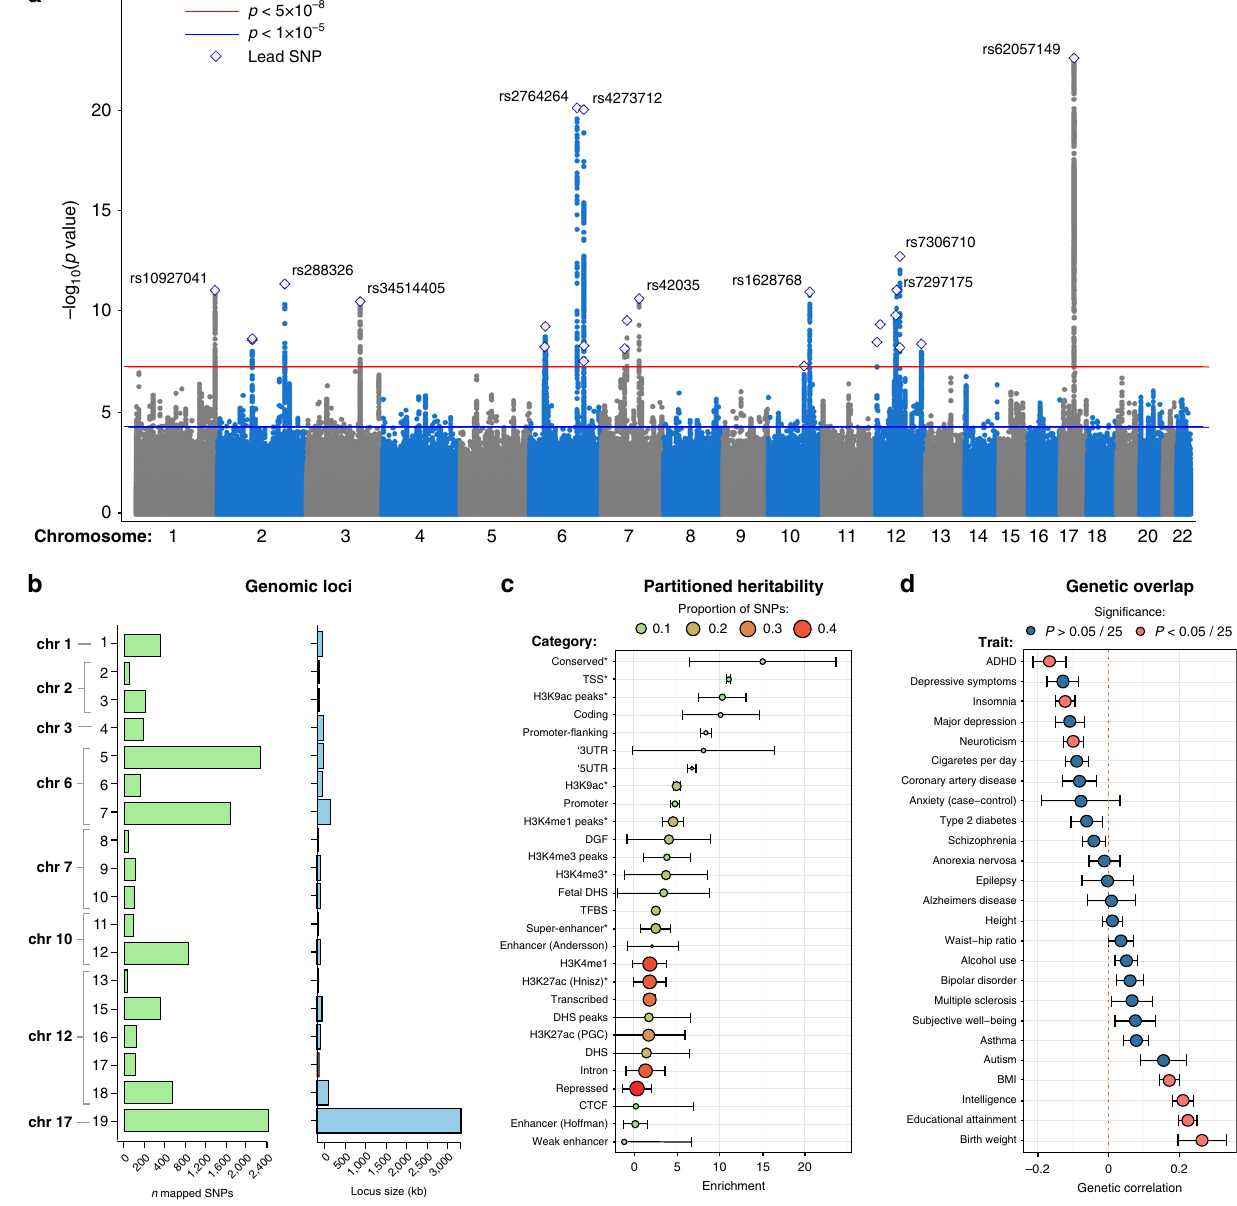
Fig. 1 Genome-wide meta-analysis and follow-up analyses of brain volume (BV). a Manhattan plot of the GWAS meta-analysis of BV in 47,316 individuals showing the genomic position of each variant on the x -axis and the meta-analysis negative log 10 -transformed P- value on the y -axis. Independent lead variants of each locus are annotated by a diamond. The horizontal red line indicates the genome-wide signi fi cance threshold that corresponds to a P - value of 5 × 10 − 8 , while the horizontal blue indicates the suggestive threshold of 1 × 10 − 5 . b Overview of the genomic loci sizes and number of variants mapped by each locus. Note that we detected 19 loci, but report 18, as we were less con fi dent in one locus (see Supplementary results 2.1). c Partitioning of the SNP heritability of the BV GWAS meta-analysis by binary variant annotations using LD Score regression. Enrichment was calculated by dividing the partial heritability of a category by the proportion of variants in that category (proportion indicated by color and size of the dots). Signi fi cant enrichments, corrected for the number of categories tested ( P < 0.05/28), are highlighted with an asterisk. d Genetic correlations with previous traits estimated using LD Score regression. Red dots denote signi fi cant genetic correlation after Bonferroni correction ( P < 0.05/25), the vertical dashed line represents a genetic correlation of 0. Error bars represent standard errors of the